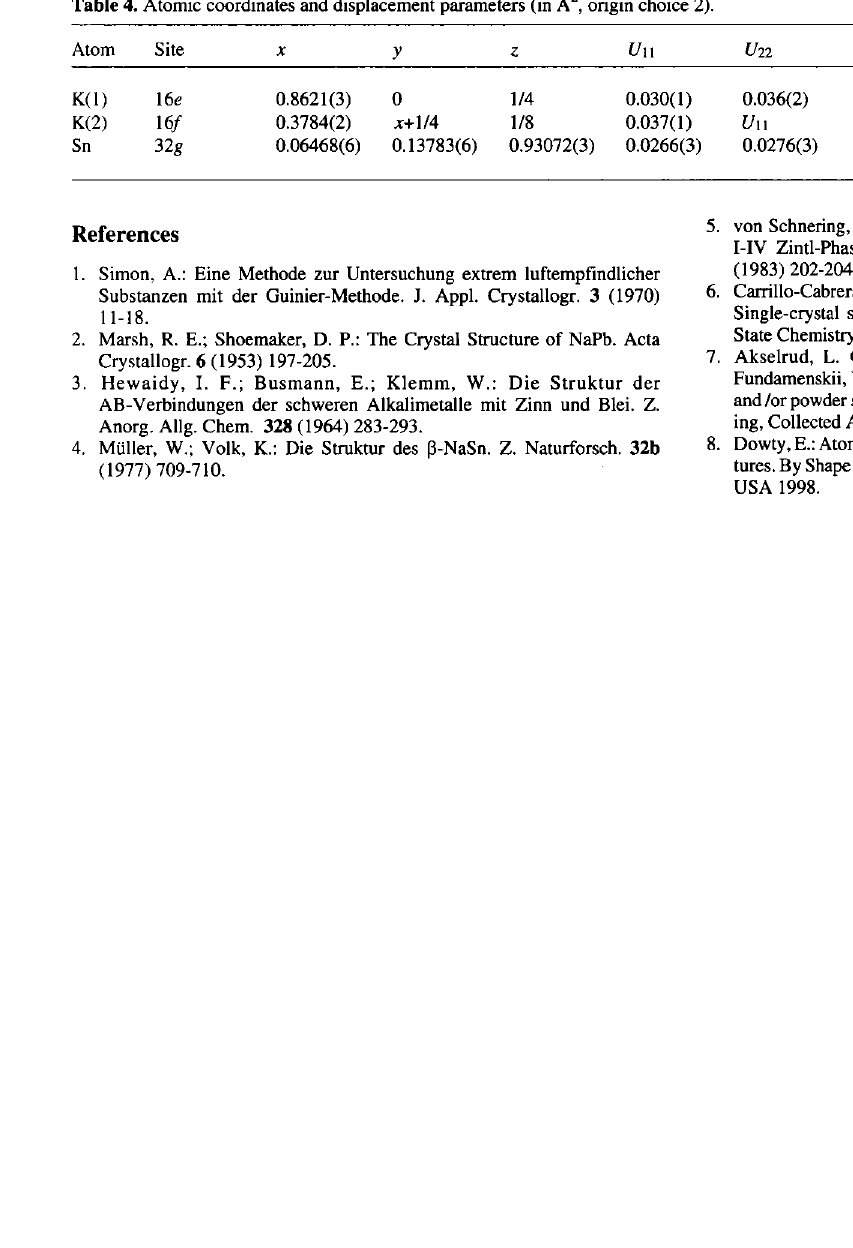
Table 4. Atomic coordinates and displacement parameters (in Ä 2 , origin choice